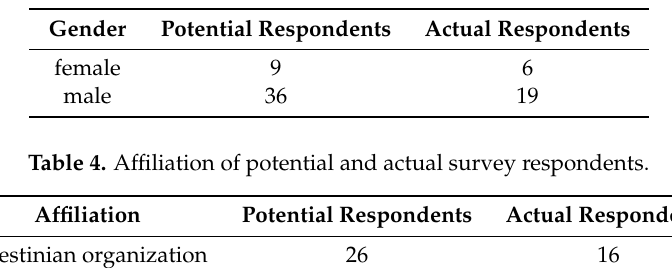
Table 3. Gender distribution of potential and actual survey respondents.